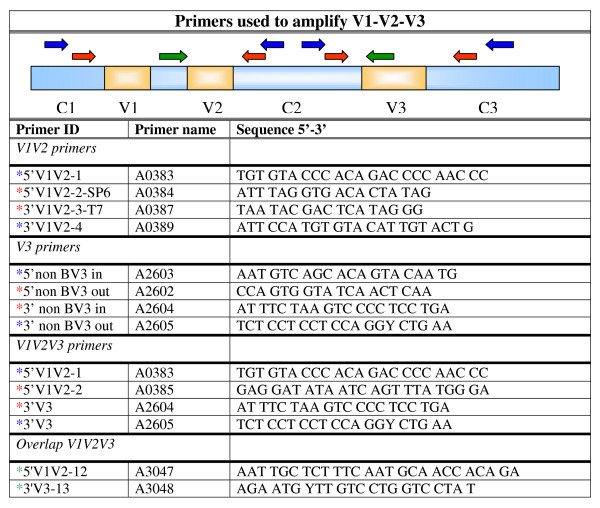
PCR Primers used to amplify V1-V2-V3 fragment. A display of the primer sequences used to amplify the V1-V3 fragment located on the viral genome of the HIV-1 env protein. External PCR: primers indicated with a blue *. Internal PCR primers are indicated with a red * for the V regions and with a green * for the C regions.